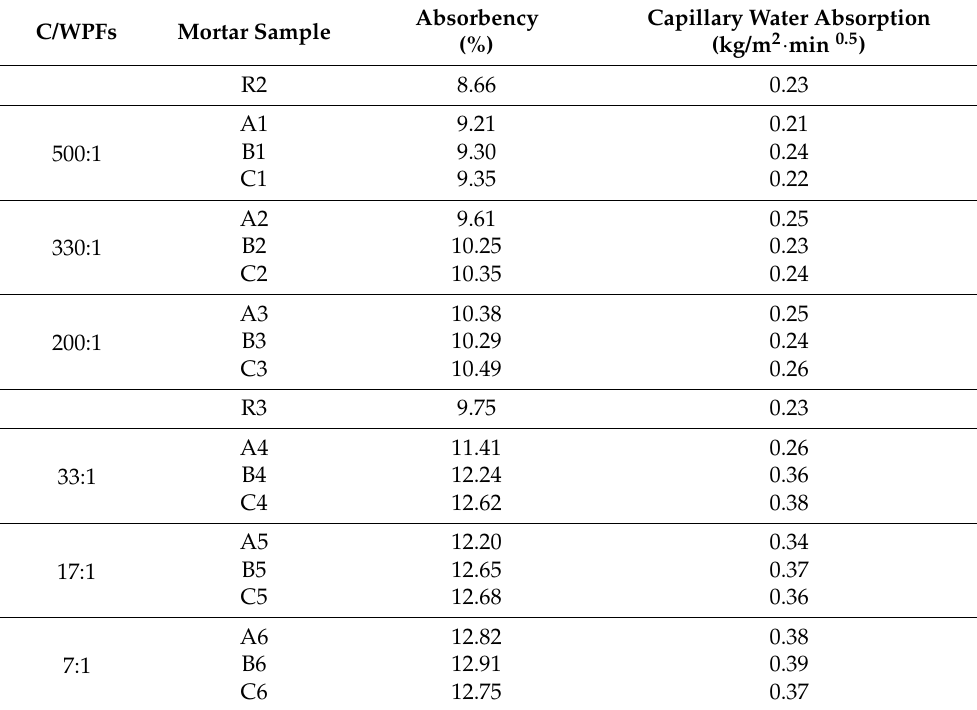
Table 7. Values of absorbency and capillary water absorption for 28-day hardened fiber-cement mortars. C/WPFs Mortar Sample